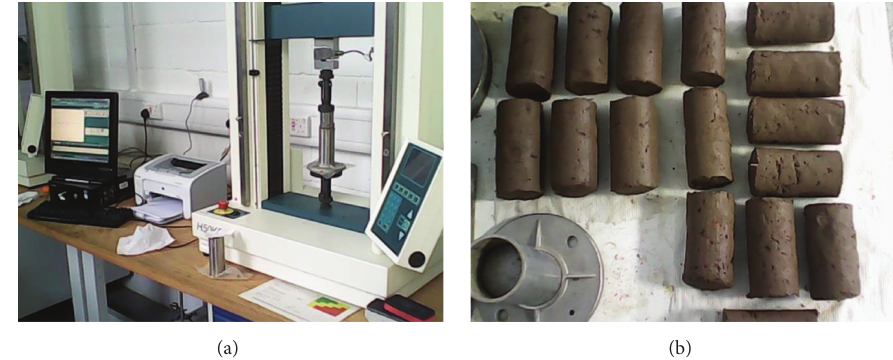
Figure 2: (a) Specimen under compaction, (b) specimen extruded from mould.